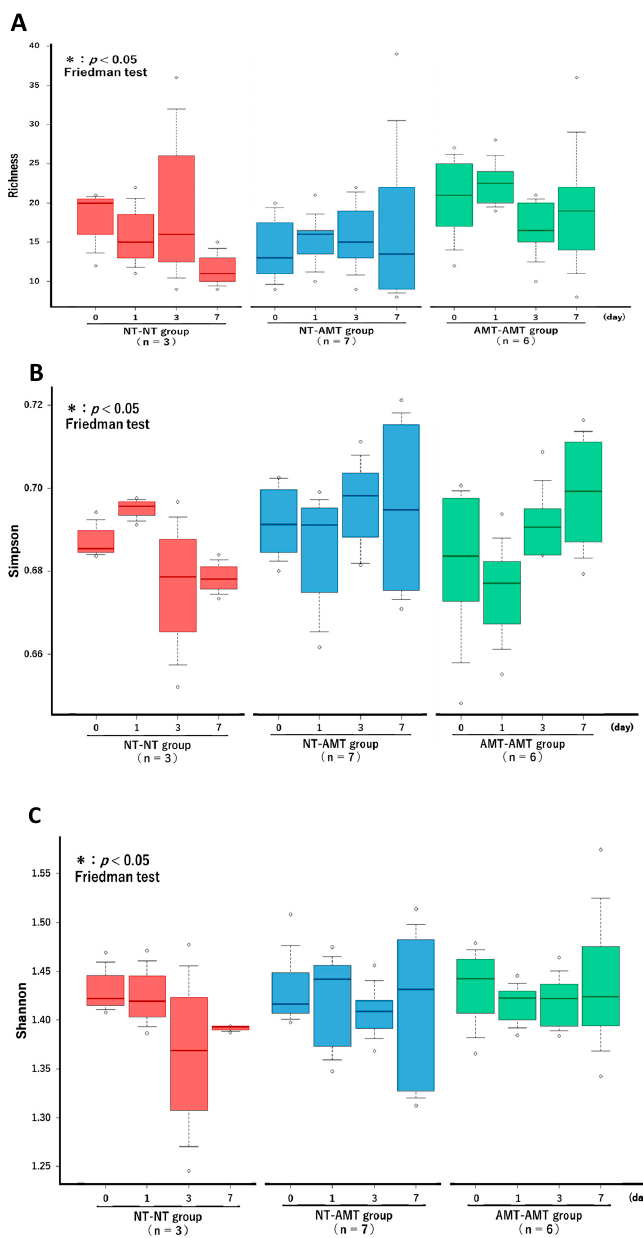
Figure 3. The changes in the Richness ( A ), Simpson’s index ( B ) and Shannon–Wiener index ( C ) over time (day 0, 1, 3, 7) in each treatment group (NT-NT, NT-AMT, AMT-AMT) for mastitis with Gram-positive bacteria. Bars represent standard deviation of the mean. Day 0 to day 7 changes in the richness and alpha diversity in each treatment group, as analyzed by the Friedman test. There were no significant differences among days (day 0, 1, 3, 7) within each treatment group in either Richness ( A ), Simpson’s index ( B ) or Shannon–Wiener index ( C ).